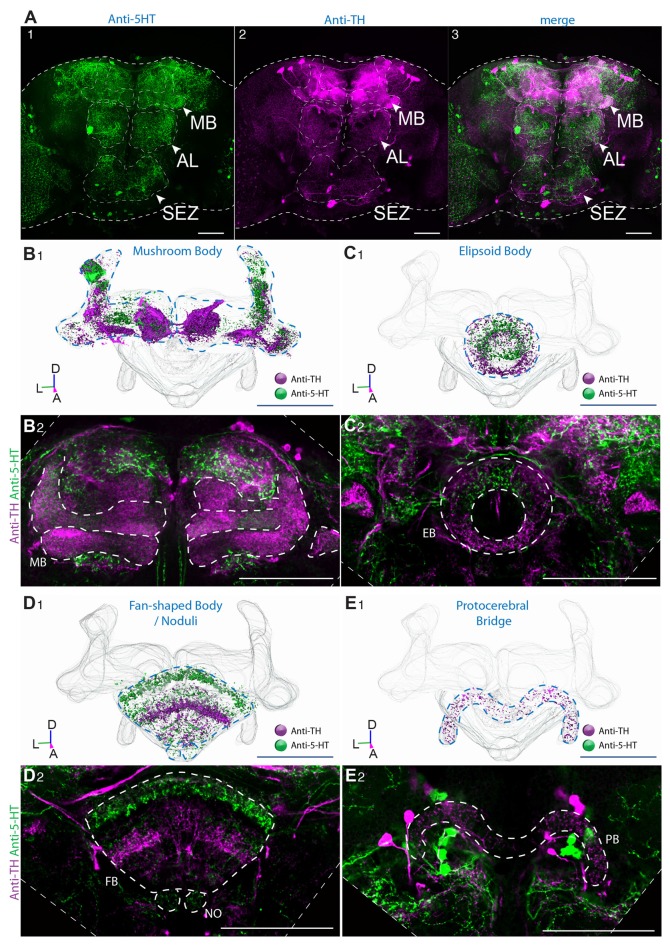
Innervation pattern of dopaminergic and serotoninergic neurons in the adult wild-type Drosophila central brain. (A) Anti-5-HT (1) and anti-TH (2) immunoreactive neurons show to some degree complementary innervation patterns in the Drosophila brain. 5-HT-producing neurons strongly innervate the AL (A) and only weakly the MBs (B1,2). TH-positive neurons innervate only the outer rim of the AL (A2,3), but strongly the mushroom body (MB) (B1,2). The tips of the α’ lobes are innervated by both populations of aminergic neurons (B1–2). Innervation pattern of 5-HT neurons and dopamine (DA) neurons in the ellipsoid body (C1,2, EB) and the fan-shaped body (D1–2, FB). 5-HT-producing neurons innervate strongly the inner rim of the EB (C1,2) and the dorsal part of the FB (D1,2). DA-producing neurons innervate strongly the outer rim of the EB (C1,2) and the ventral part of the FB (D1,2). The protocerebral bridge (PB) is innervated by DA, but by 5-HT producing neurons (E1,2). 3D reconstruction of the MB (B1), EB (C1), the FB (D1) and the PB (E1) with DA and 5-HT IR indicated in different colors (D, dorsal; L, lateral; P, posterior; A, anterior). Scale bars: 50 μm.